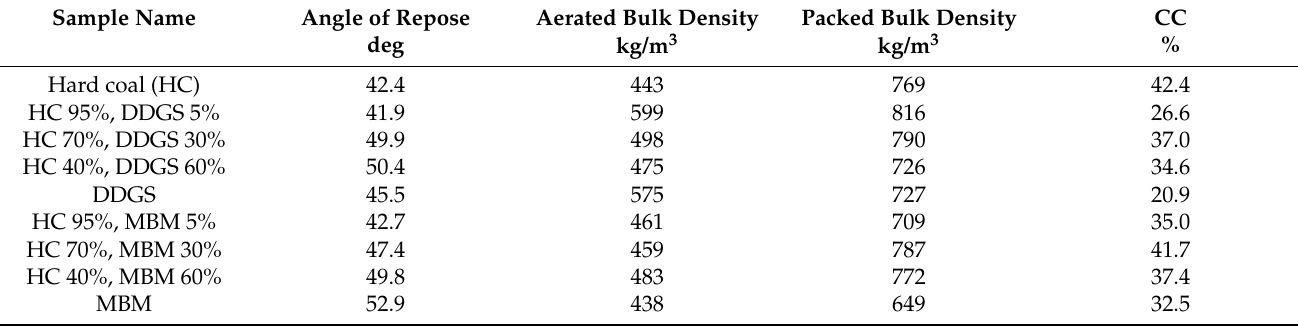
Table 2. Selected properties of the tested